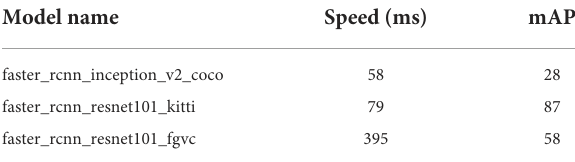
TABLE 4 Comparison of Speed and mAP of different models.